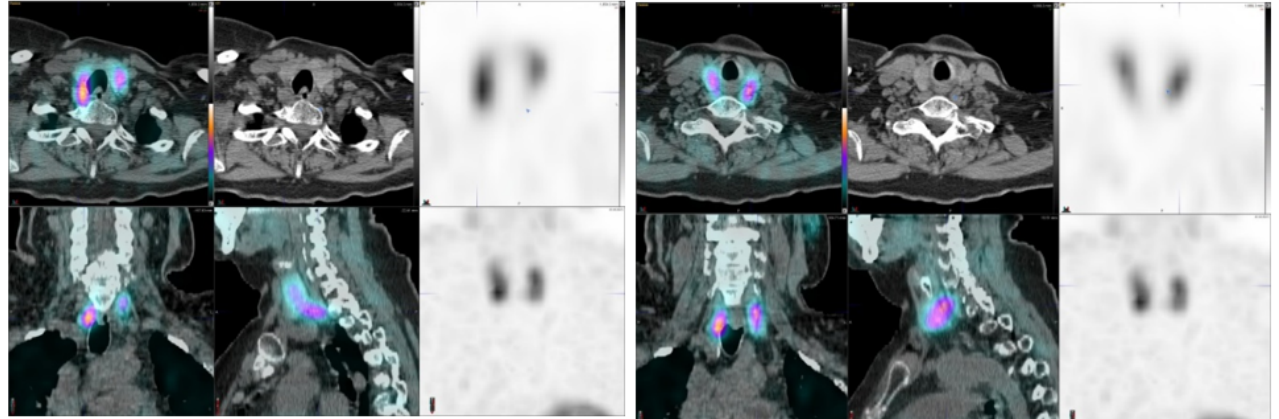
Figure 4. Parathyroid adenoma, on the right (inferior), on the left (superior). This 69-year-old female patient was not operated. Her S-PTH concentration was 113 ng/L and S-Ca 11.0 µ g/L. The SUVmax values of the right-sided adenoma were 10.4 (CGZAS) and 7.8 (CGAS), respectively. Visually, this uptake was moderate (2 < TBR < 3) and lesion diameters on CT were 11 mm × 24 mm. The adenoma on the left demonstrated slightly higher SUVmax values: 12 (CGZAS) and 9.3 (CGAS), respectively. Visually this uptake was weaker, but moderate (2 < TBR < 3) and the lesion diameters on CT were 17 mm × 38 mm.